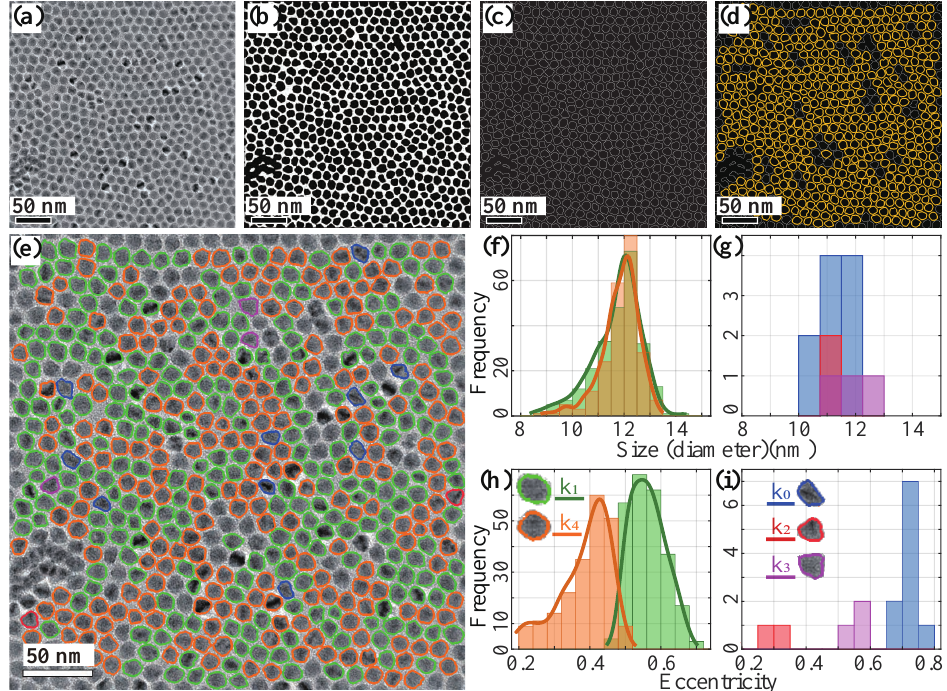
Figure 5. Image pre-processing and shape classification of the QDs. ( a ) BF-TEM image of the CdS/ZnSe QDs sample. ( b ) Binary image after the dynamic background processing. ( c ) Particle edges detected by the Canny Edge detection method. ( d ) Convexity filtered particle contours (yellow), where all the non-convex particle aggregates (grey) are filtered out. ( e ) Classified particle contours labeled with different colors overlaid with the BF-TEM image shown in (a). ( f ) Size distribution of the two highest population clusters. ( g ) Size distribution of the three lowest population clusters. ( h ) Eccentricity distribution of the high population clusters of k 1 and k 4 . ( i ) Eccentricity distribution of the low population